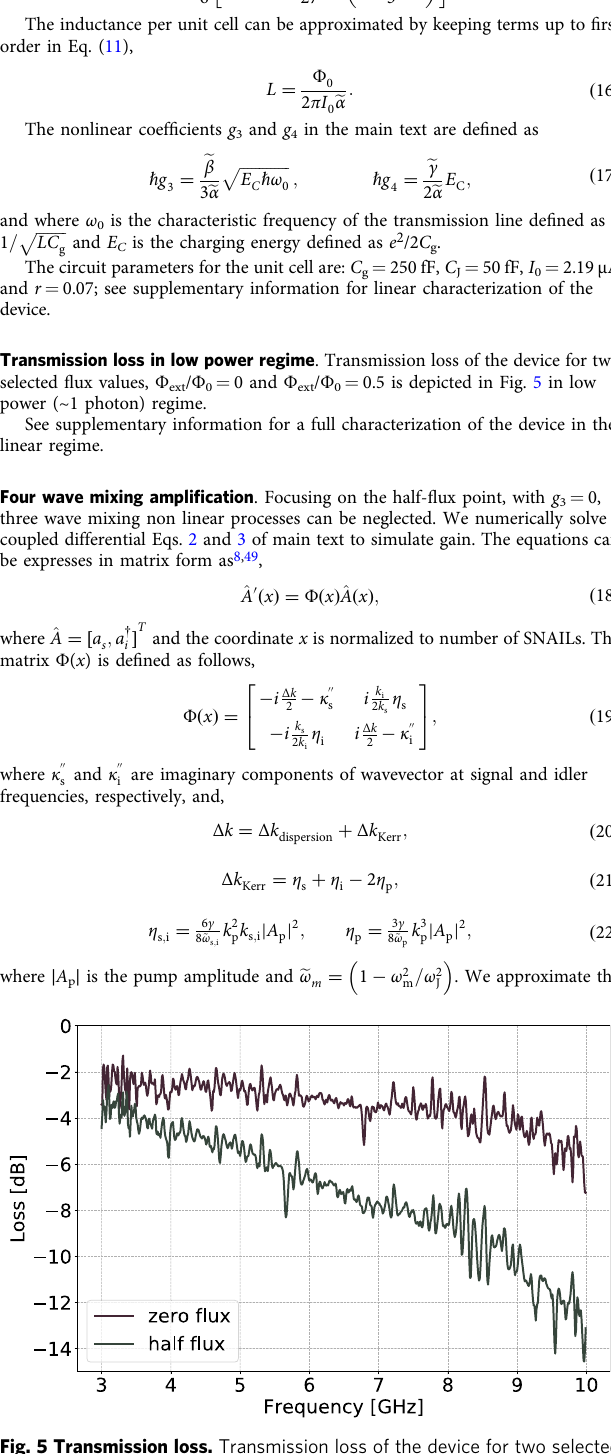
Φ = 0.5 in low power (~1 photon) ext / 0